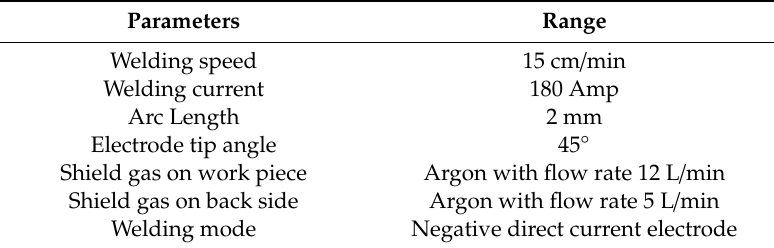
Figure 3. Test specimen for the tensile test (units in mm).